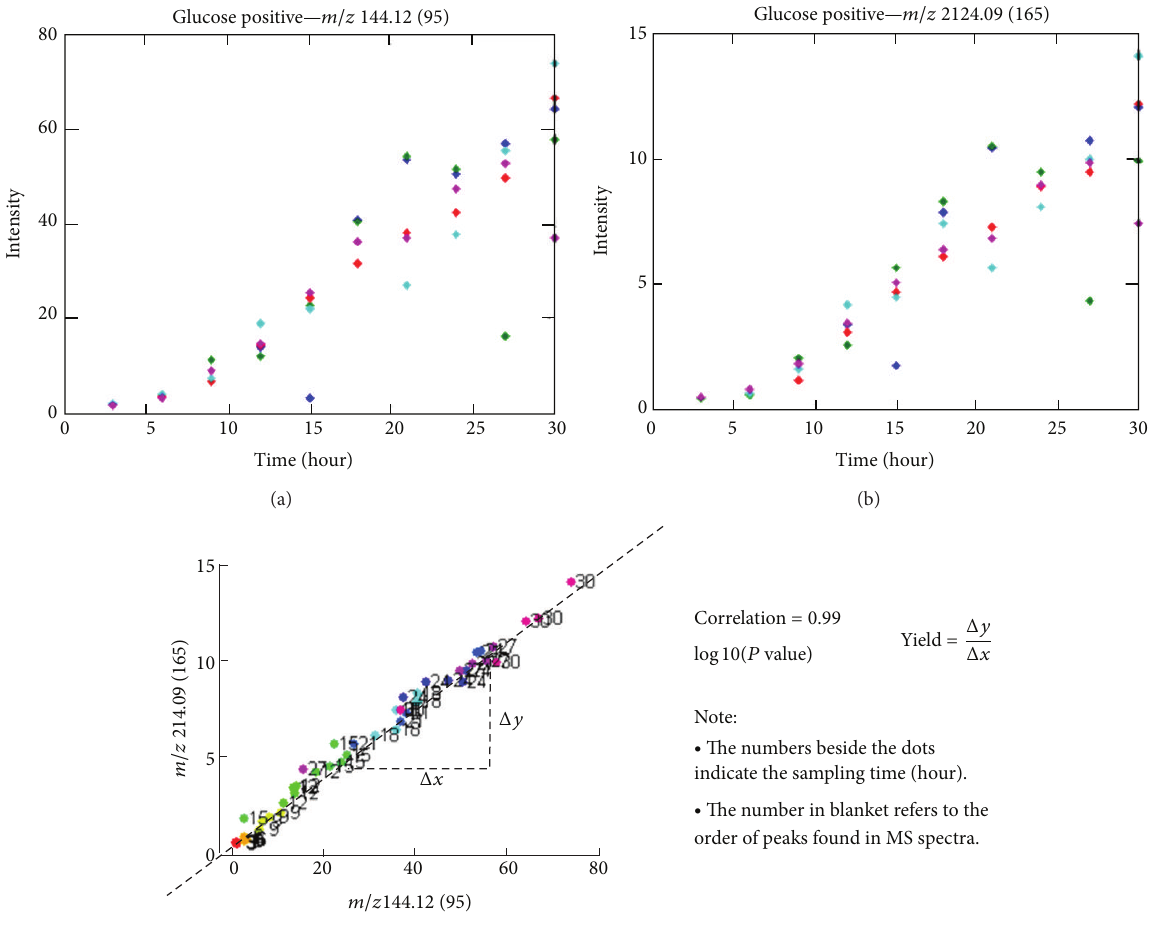
Figure 2: The cherry-picking process illustrated. Two upper figures show two selected metabolites during the first step, and the lower figure shows their corresponding correlation in time. Both metabolites will be picked. Slopes (yields) in the matrix that had a 𝑃 value less than 0.01 were set to zero.